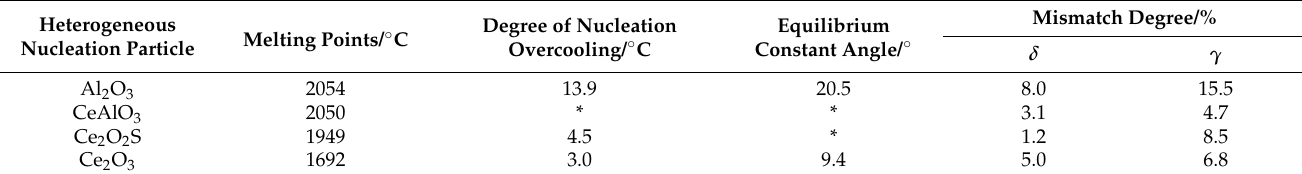
Table 5. Physical properties of the second-phase particles during the solidification of molten steel. Heterogeneous Nucleation